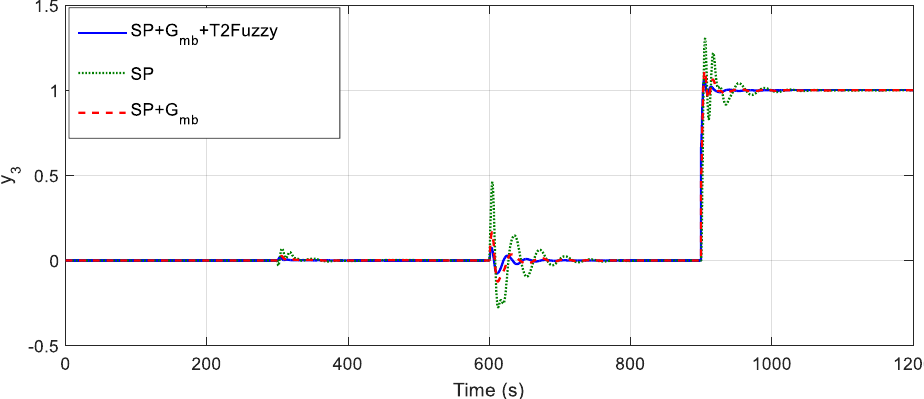
Figure 21. Performance of three control methods for 𝑦 3 .